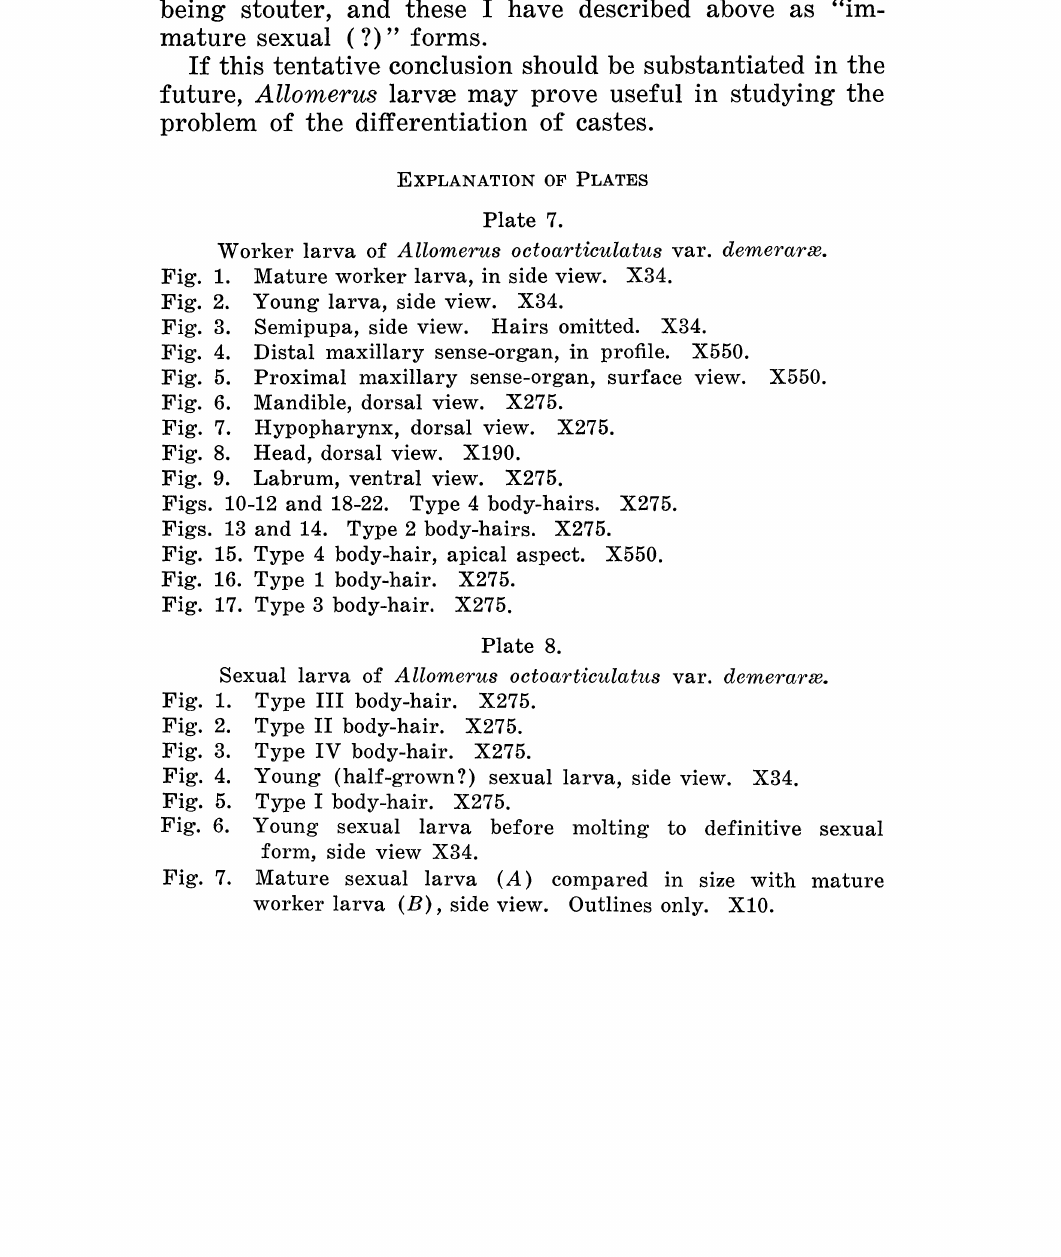
EXPLANATION OF PLATES Plate 7. Worker larva of Allomerus octoarticulatus var. demerarx.